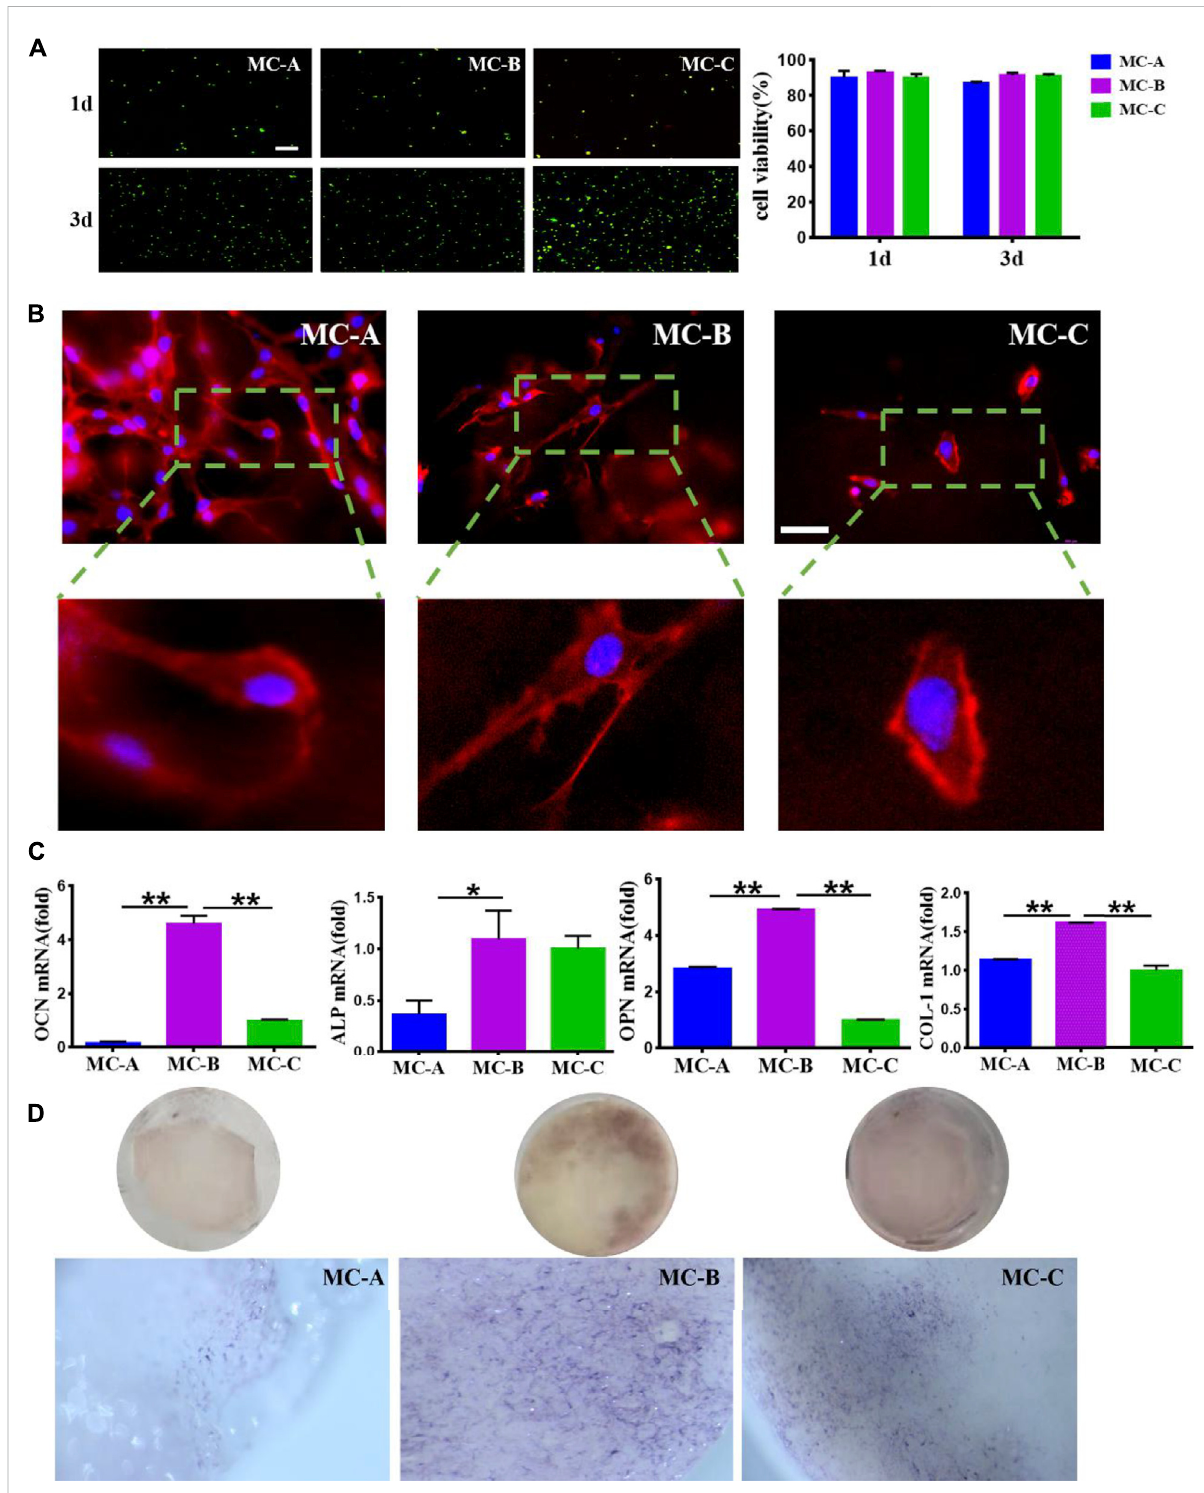
FIGURE 3 Effects of MC-A, MC-B, and MC-C on MC3T3-E1 cells. (A) Live/dead cell staining (scale bar: 100 μ m); (B) Effects of MC-A, MC-B, and MC-C on themorphology of MC3T3-E1 cells weredetected by rhodaminelabeled phalloidinstaining (scale bar: 50 μ m); (C) The expression of theosteogenic gene was detected by qRT-PCR; (D) ALP staining (stereomicroscope, x60). Data are presented as mean ± SD. *p < 0.05 ; **p < 0.01